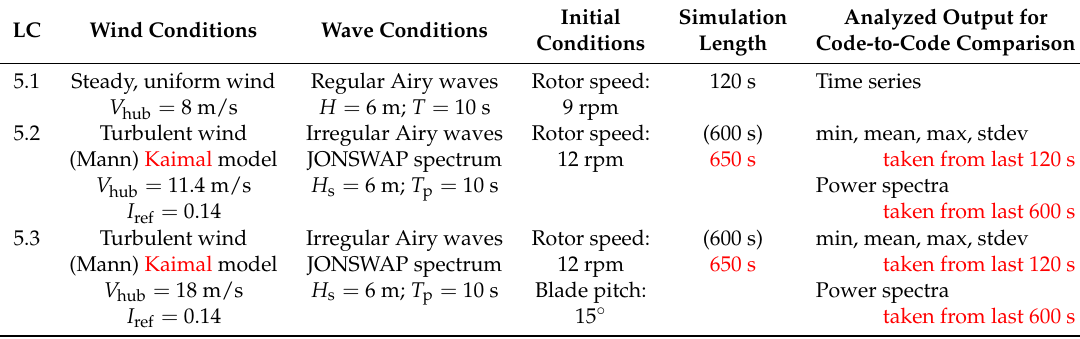
Table 8. Simulation settings and analysis methods for LC group 5.x, assumptions and modifications are written in